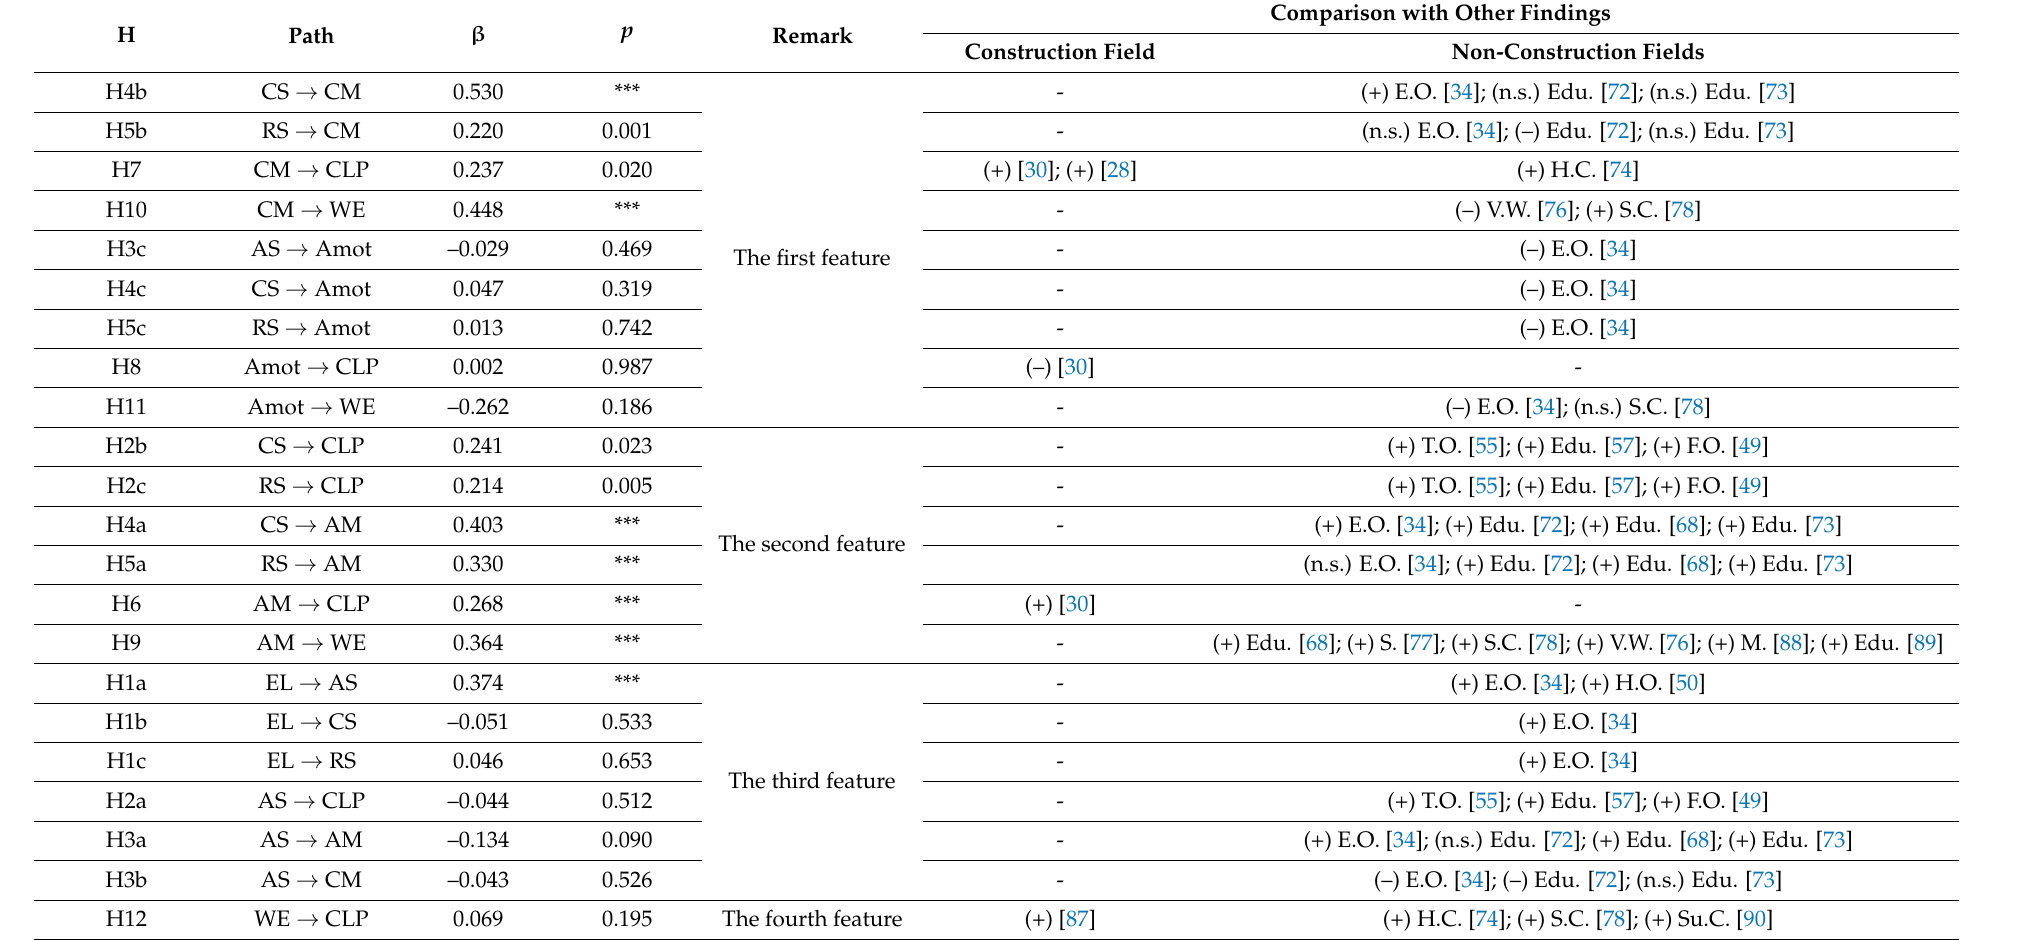
Table 6. Regression weights for the final structural